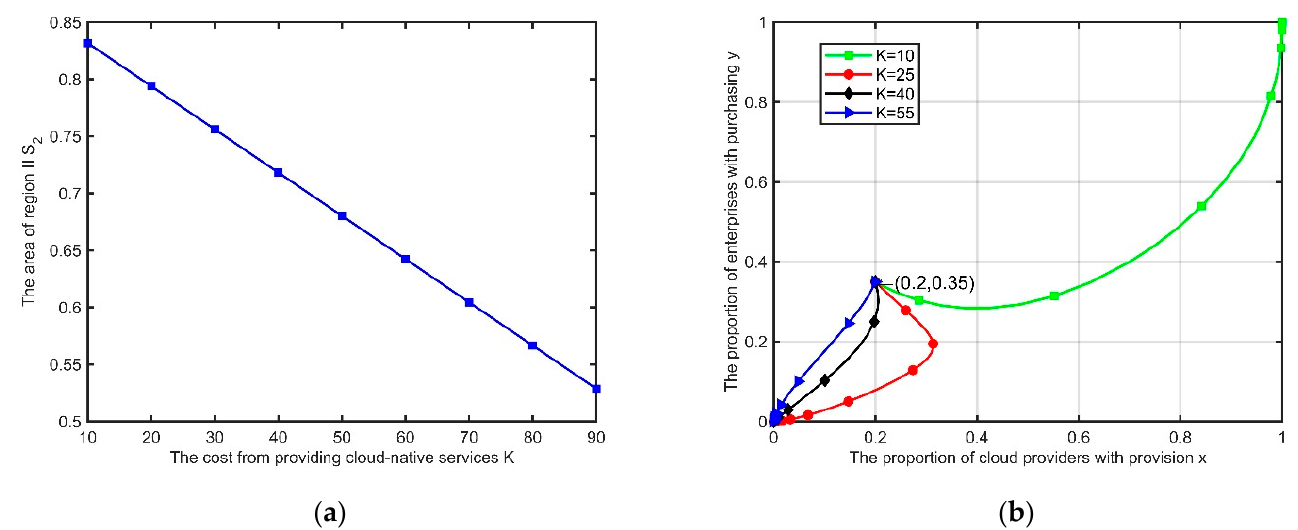
Figure 8. The impact of C 1 on S II and evolutionary paths ( a ) The impact of C 1 on S II ; ( b ) The evolutionary paths with different costs C 1 .